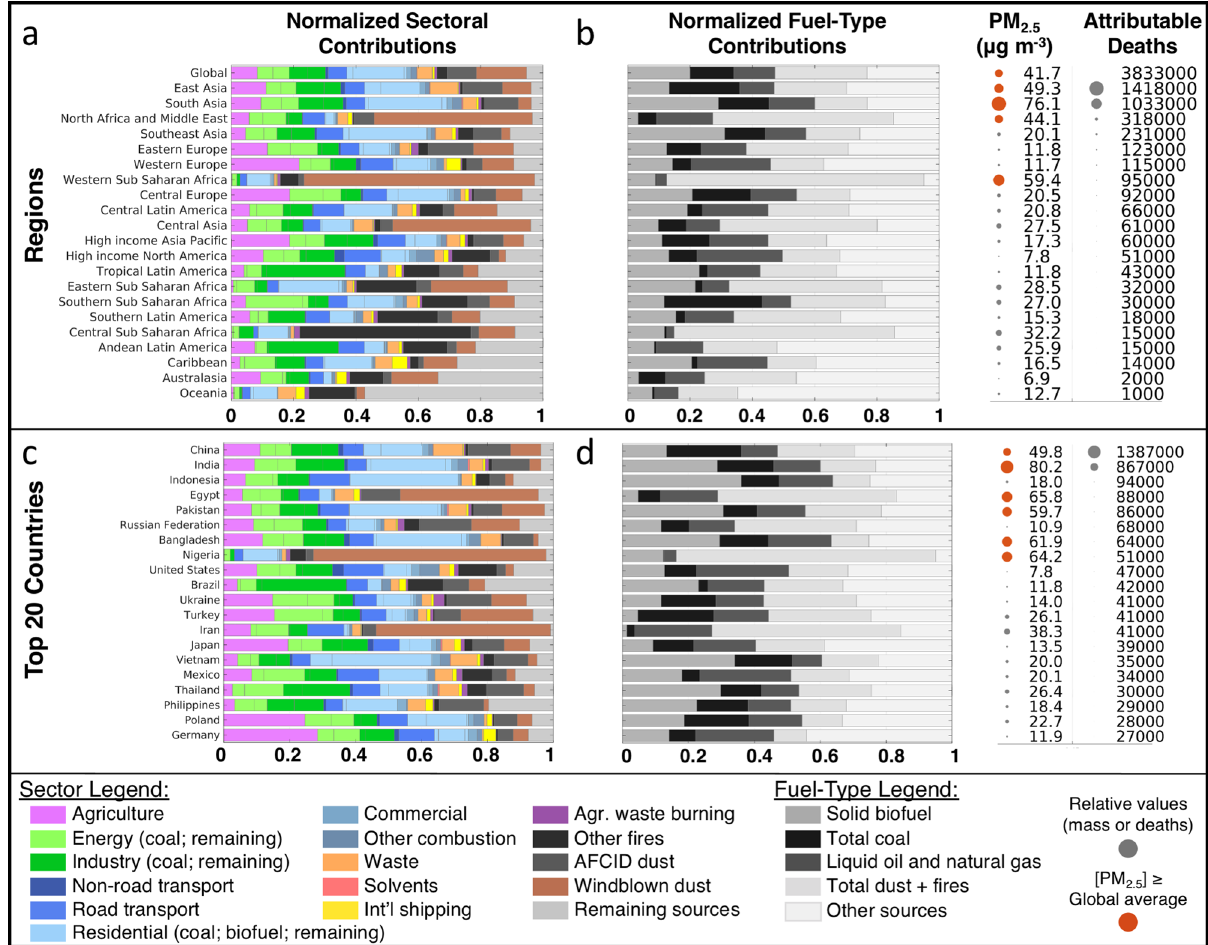
Fig. 3 Relative (fractional) source and fuel contributions to annual population-weighted mean PM 2.5 mass and attributable deaths in 2017. a , c Normalized sectoral source contributions for 21 world regions and the global average ( a ) and top 20 countries ( c ). Sorted by decreasing number of ambient PM 2.5 -attributable deaths (rounded to the nearest 1000). b , d Normalized contributions from the combustion of three fuel categories and remaining PM 2.5 sources. To the right of b and d , annual population-weighted mean PM 2.5 concentrations and associated attributable deaths are provided for each region/country. Relative amounts are illustrated by relative dot sizes. Concentrations above or equal to the global average are colored the top 20 countries with the largest number of PM 2.5 -attributable deaths. The relative contributions of PM 2.5 -disease pairs for these same regions and countries are shown in Supplementary Fig. 3.